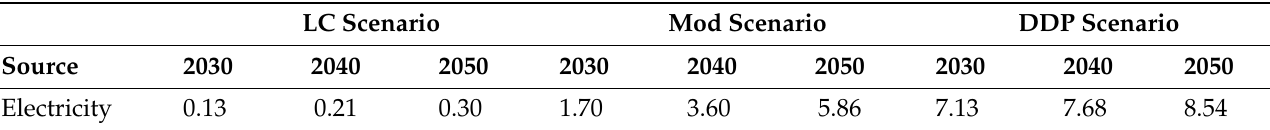
Table 8. Land transport electricity demand in